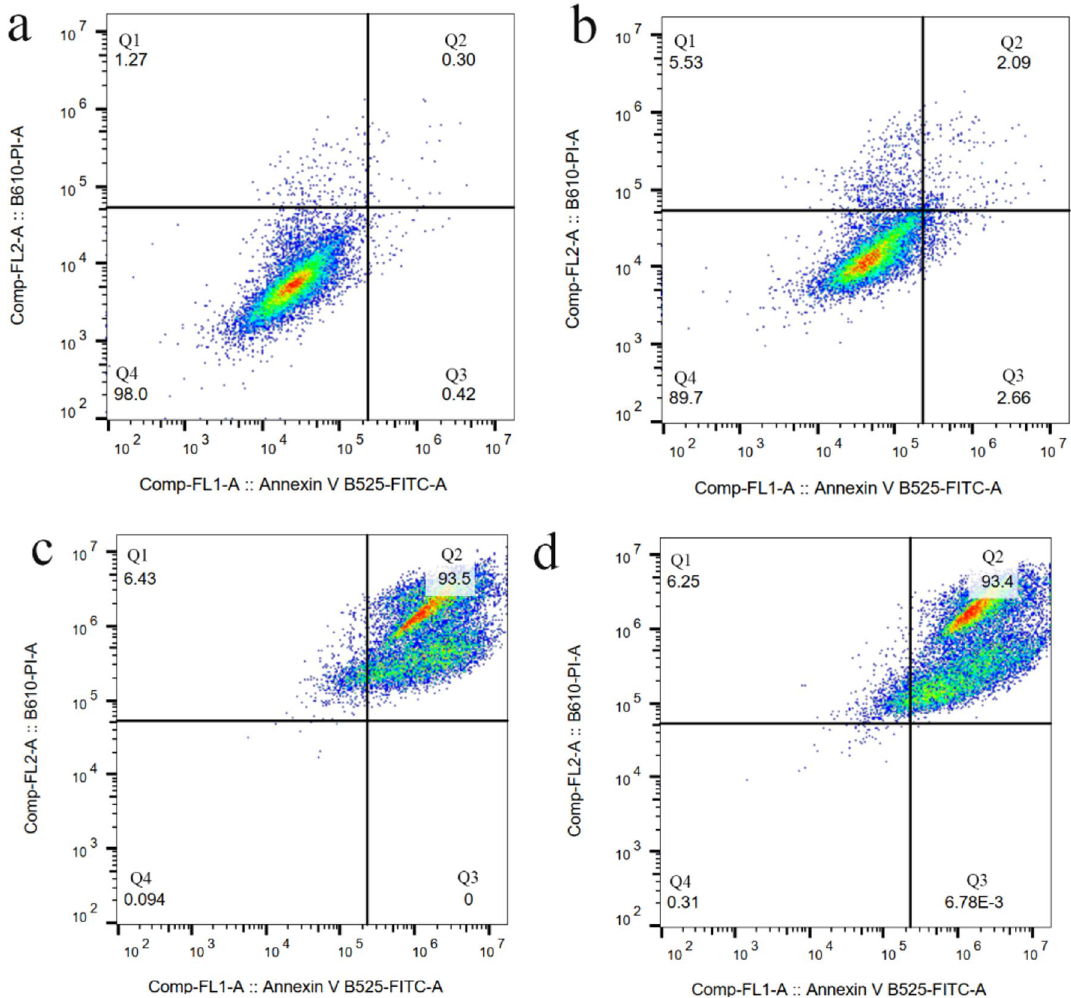
Figure 6. Flow cytometer analysis for cell apoptosis/necrosis of U251 upon 48-h treatment, stained with Annexin V-FITC and PI. ( a ) Control, ( b ) EDT-IONPs, ( c ) DOX, and ( d ) DOX-EDT-IONPs. (Q4) demonstrates Live, (Q3) early apoptotic, (Q2) late apoptotic and (Q1) necrotic